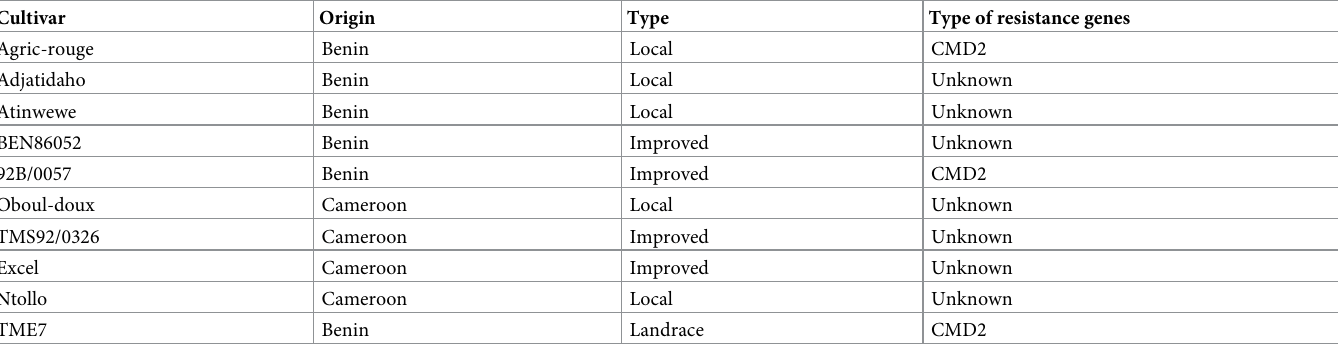
Table 1. Characteristics of cassava cultivar planting